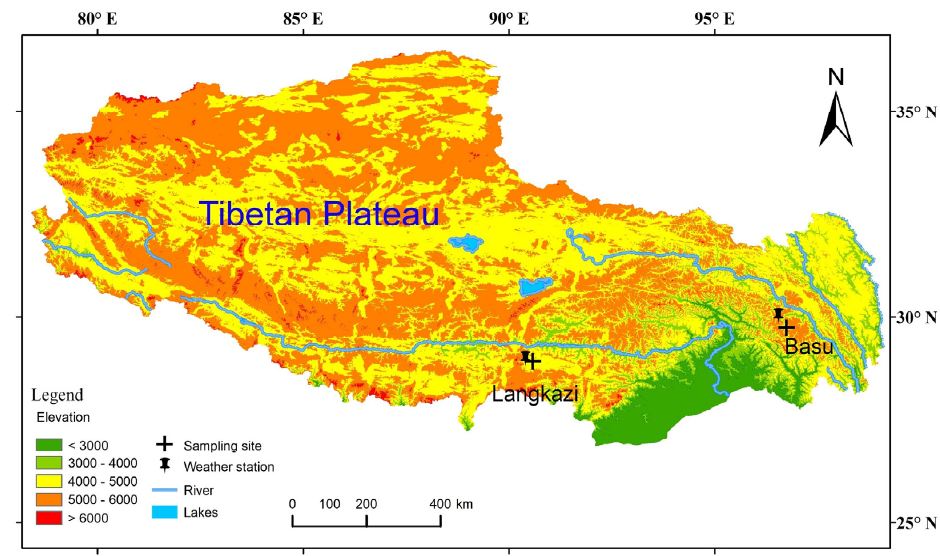
Figure 1. Location of the study sites on the Tibetan Plateau.